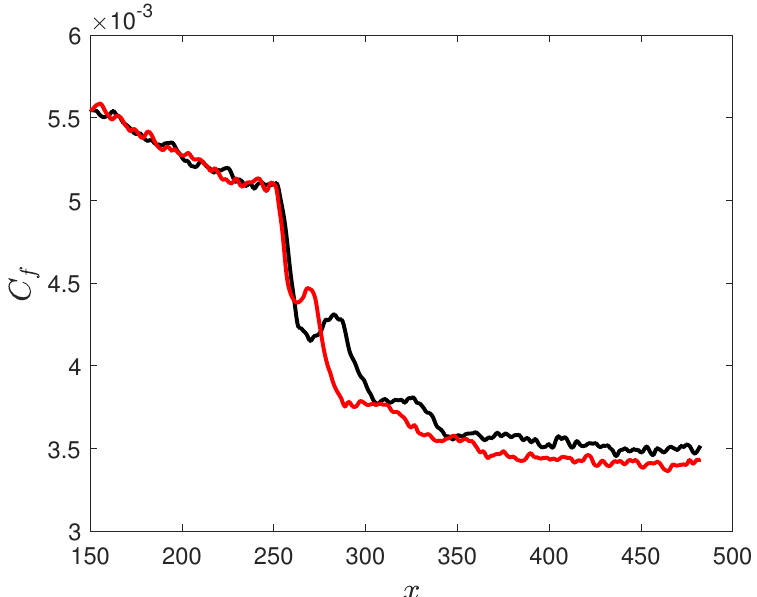
Figure 5. Skin friction coefficient for temporal oscillating wall with period T + = 176 at two dif- ferent phases (black line φ = 0 ◦ and red line φ = 90 ◦ ). A film illustrating all phases is given as Supplementary Material to this paper.